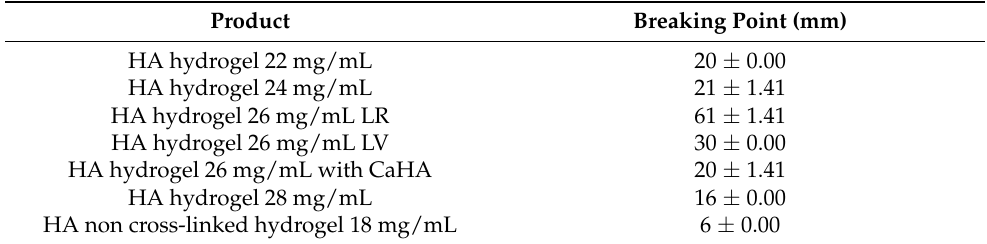
Table 4. Breaking points obtained by the resistance to elongation test of seven HA hydrogel dermal fillers provided by Matex Lab S.p.A. Data are represented as averages and standard deviations ( n = 1, replicates =